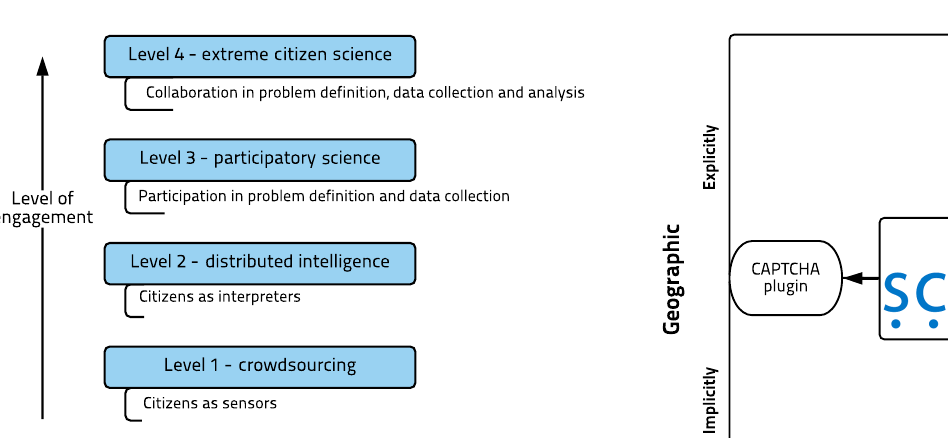
Figure 1. Levels of participation and engagement in citizen science projects. Adapted from Haklay (2013).